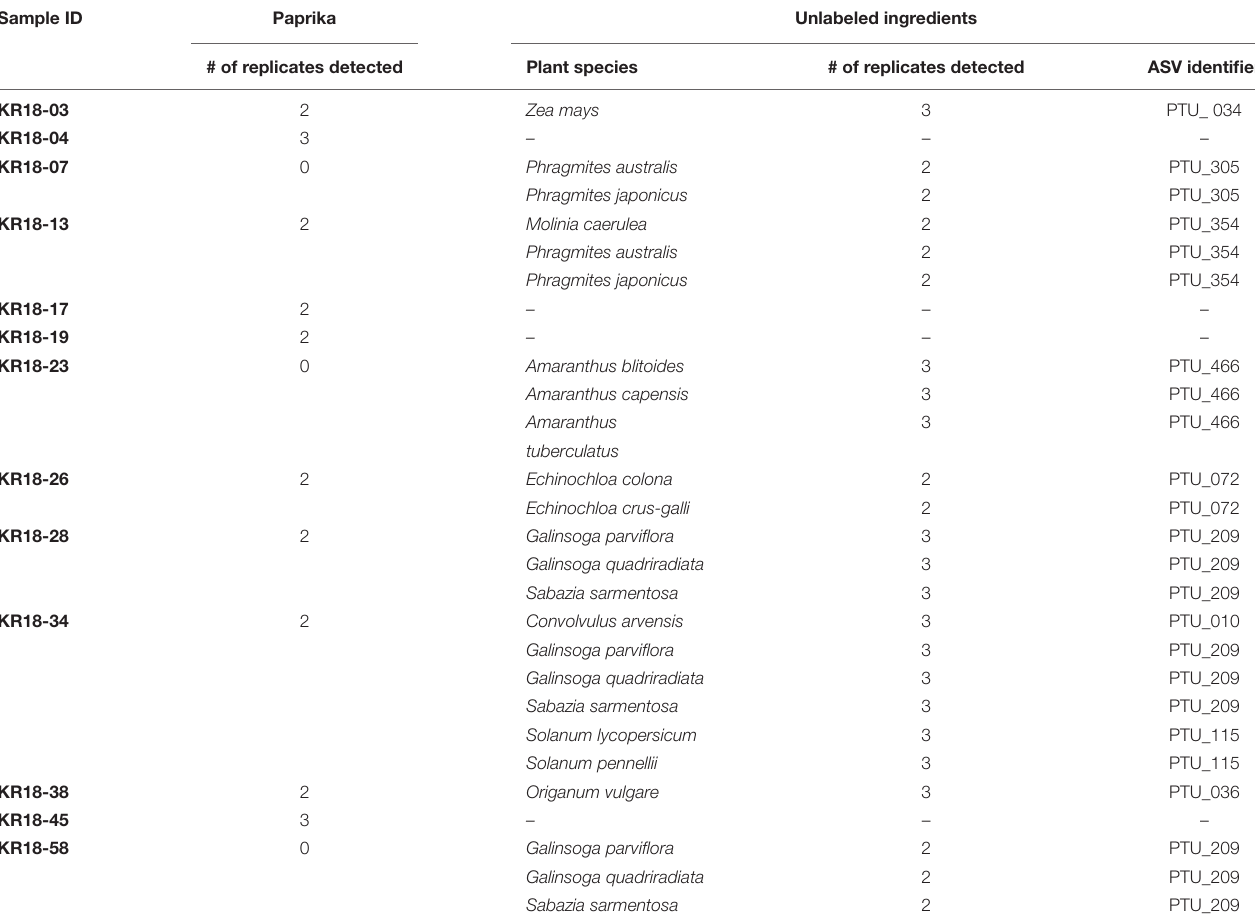
TABLE 1 | DNA metabarcoding based authentication of the products labeled as containing